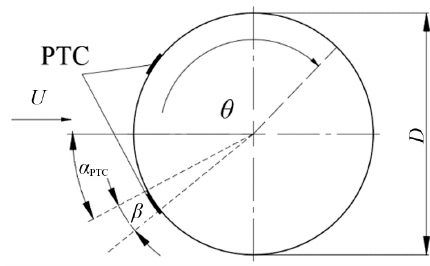
Figure 2. Details of the roughness strip.